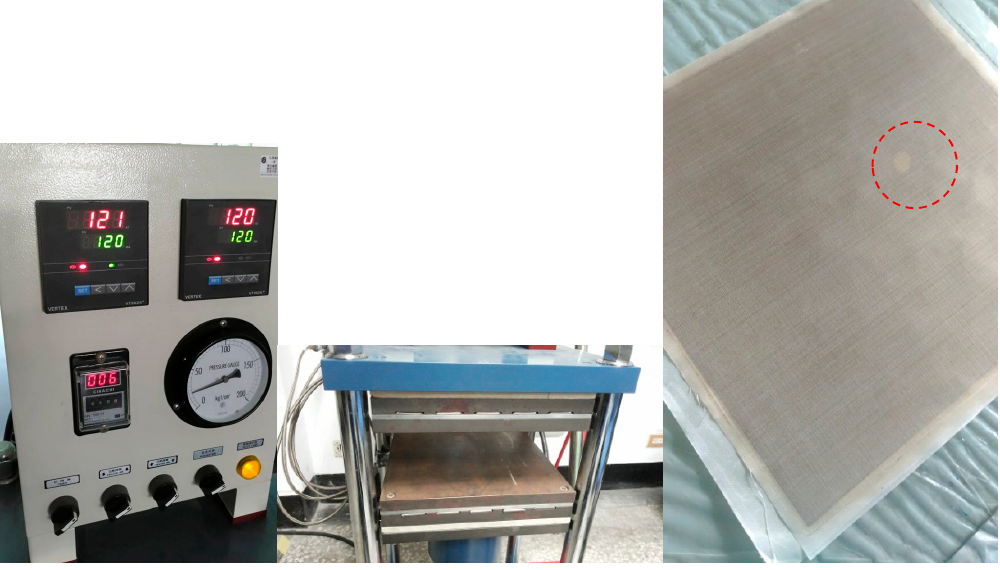
Figure 4. Equipment of composite plate manufacturing ( left ) and the plate with a hole marked in red circle ( right ).